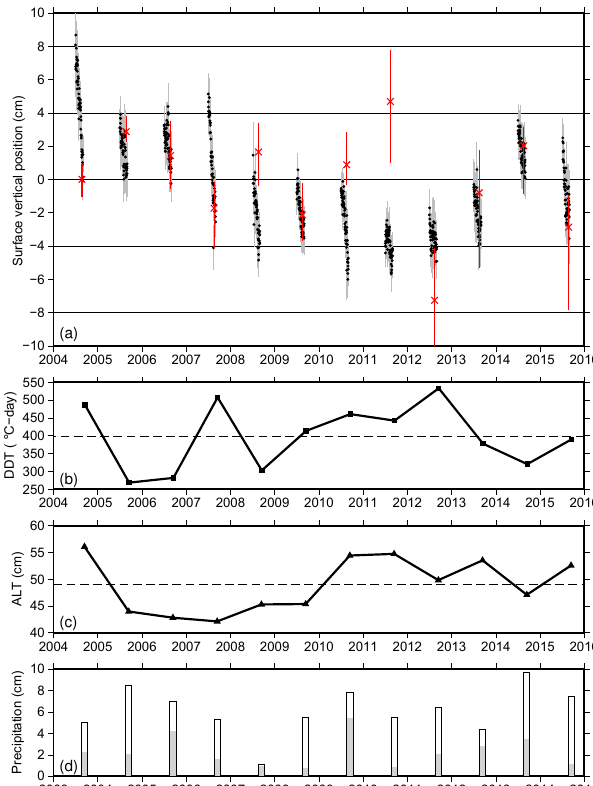
Figure 4. (a) De-meaned time series of surface vertical position. The black dots are the daily vertical positions of the reflecting sur- face at SG27, retrieved using GPS-IR. The error bars (standard er- ror of the mean) are shown in gray. The red crosses are the vertical positions of ground measured annually in mid-August by Strelet- skiy et al. (2017), averaged over four sites at the CRREL grid, solid earth movement removed. The red bars show the range of elevation changes at the four sites. (b) Time series of the degree day of thaw- ing (DDT) at the end of each thaw season. The dashed line denotes the 2004–2015 mean level. (c) Time series of active layer thickness (ALT) at SG27, scaled from the mean ALT measured at CALM grid. The dashed line denotes the 2004–2015 mean. (d) Cumulative pre- cipitation during June–July–August (open bars) and August (gray bars), measured at the Barrow Airport. Note that the horizontal axis is shifted 1 year earlier from panel (a) to facilitate the comparison between the seasonal subsidence with precipitation in the previous summer (see more in Sect.